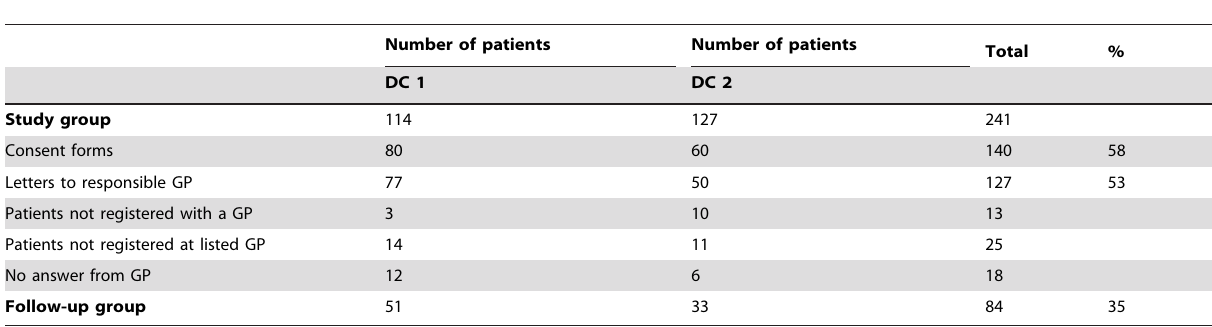
Table 1. Patients from study group included in follow-up group and response rates.